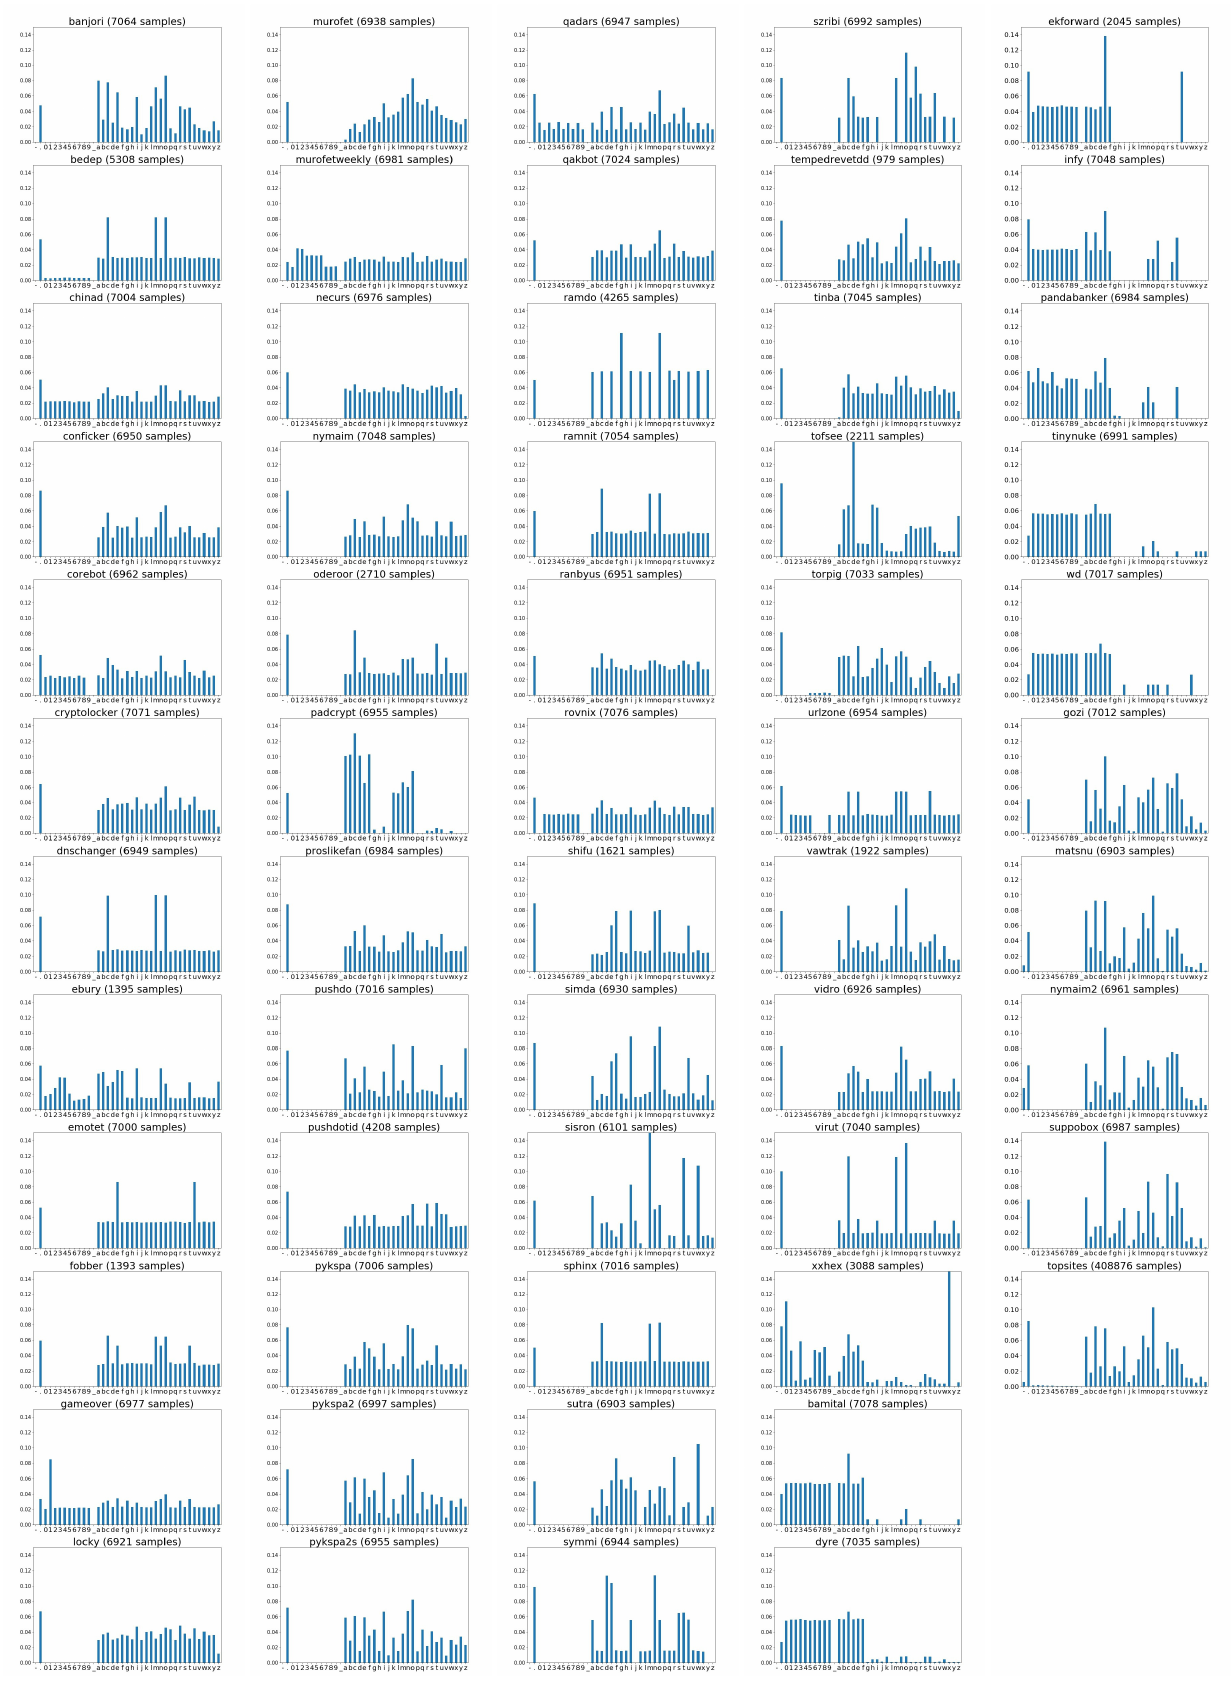
Figure 2. Unigram